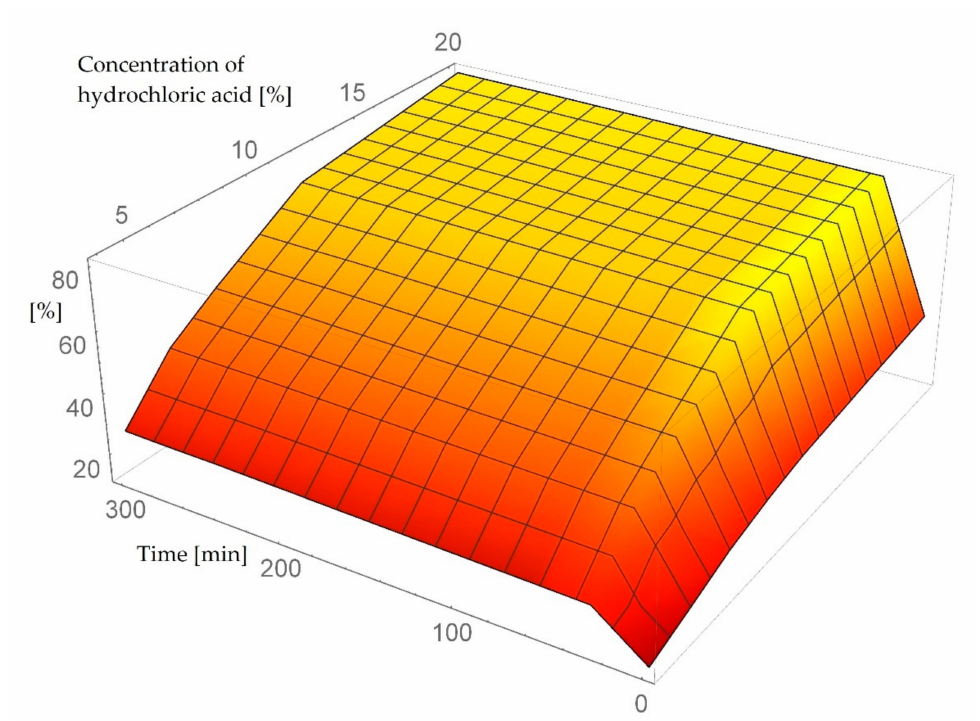
Figure 4. Extraction of iron from tailings. Efficiency of extraction vs. concentration of hydrochloric acid in solution and duration of activation treatment.